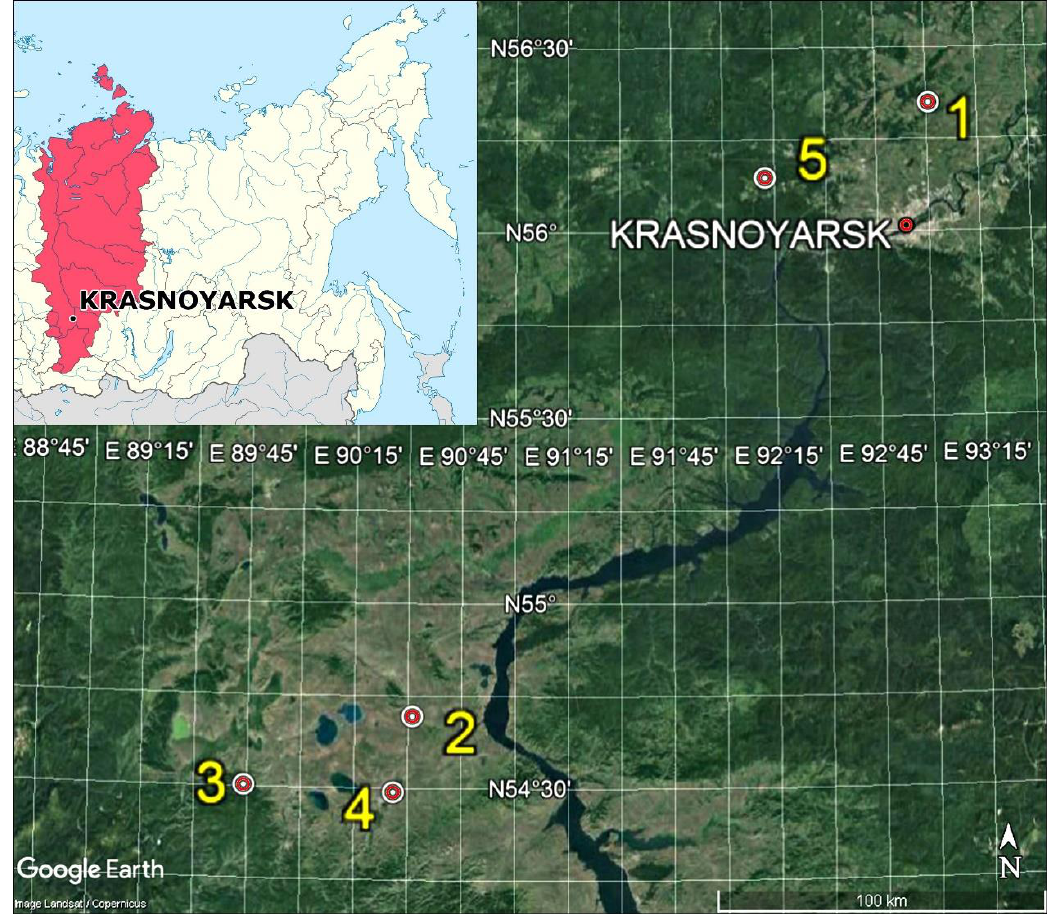
Figure 1. Location of the study areas.